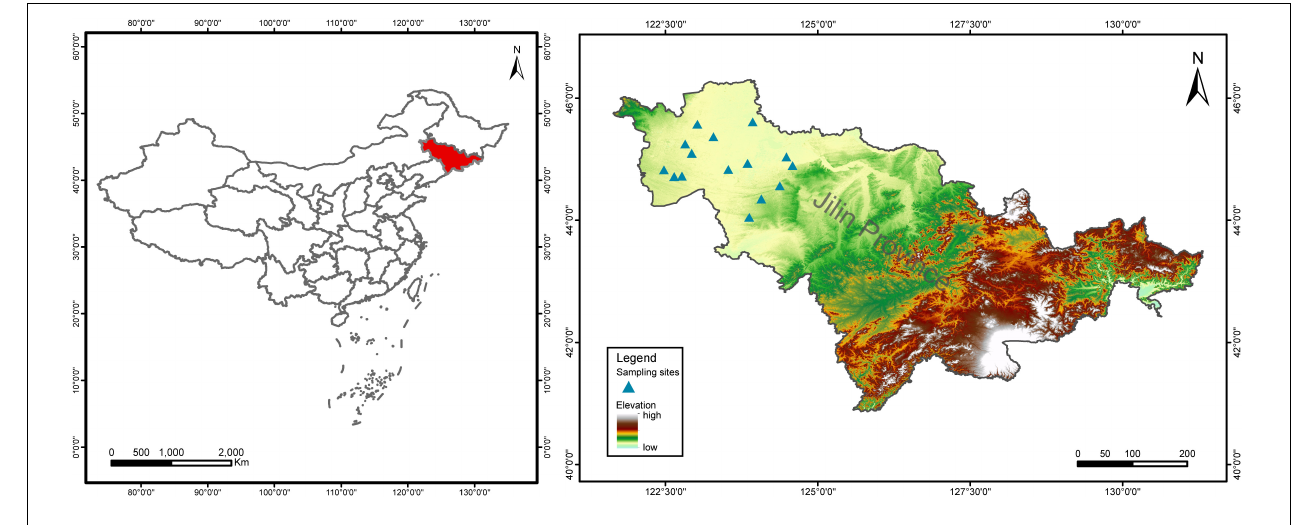
FIGURE 1 | The distribution of investigated sites in western Jilin Province,